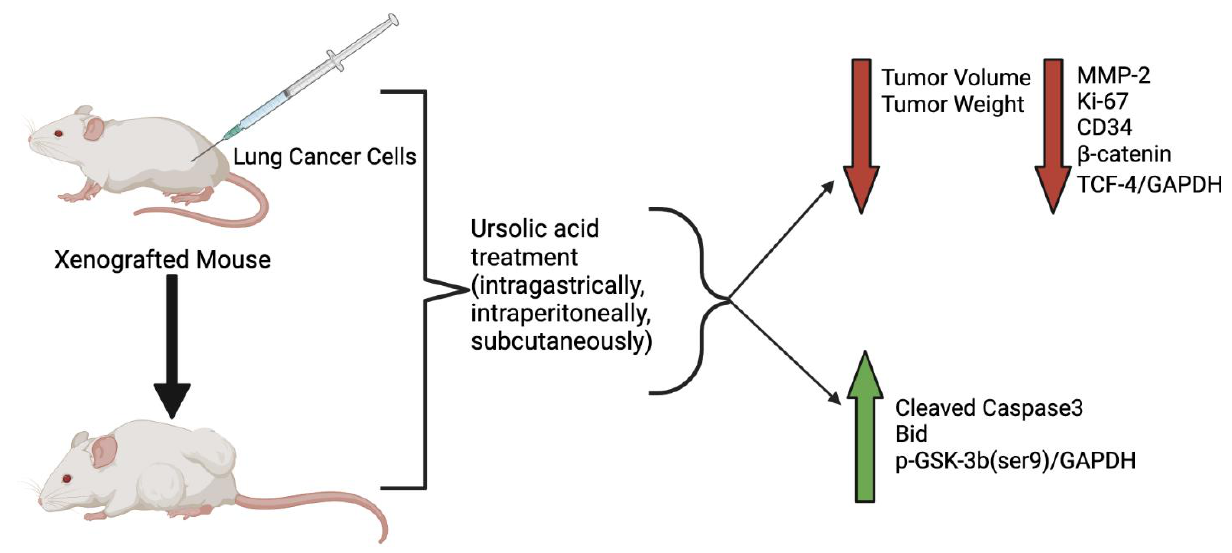
Figure 3. Effects of ursolic acid treatment on lung cancer in vivo. Mice xenografted with lung cancer cells (A549 or H1975), when treated with ursolic acid, had reduced tumor volume and weight compared to untreated animals. Ursolic acid treatment reduced the expression of MMP-2, Ki-67, CD34, β -catenin and TCF-4/GAPDH and increased cleaved caspase-3 and Bid protein levels. The figure, created using BioRender.com, is based on data from [68,71,77,78,83].